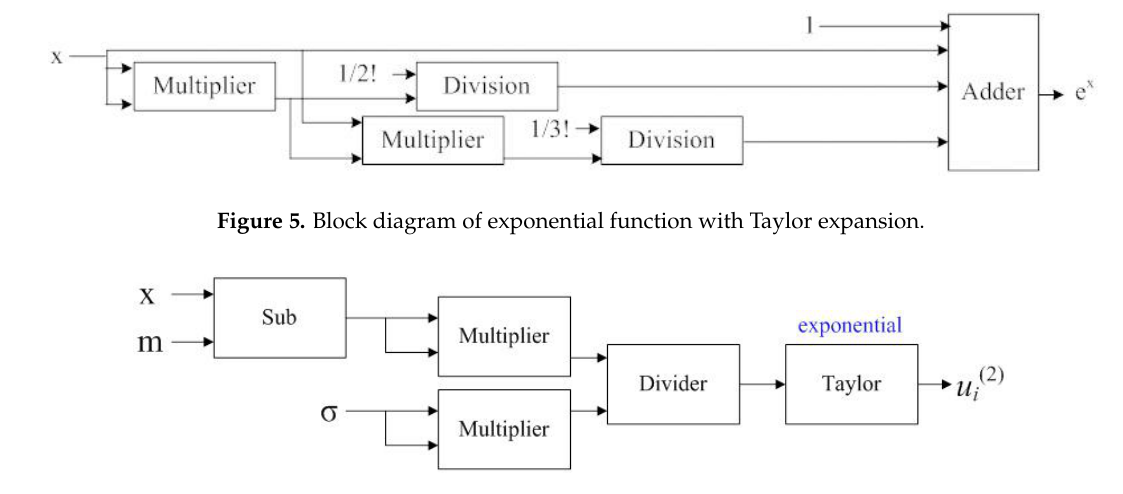
Figure 7. Taylor approximation of a Gaussian function.